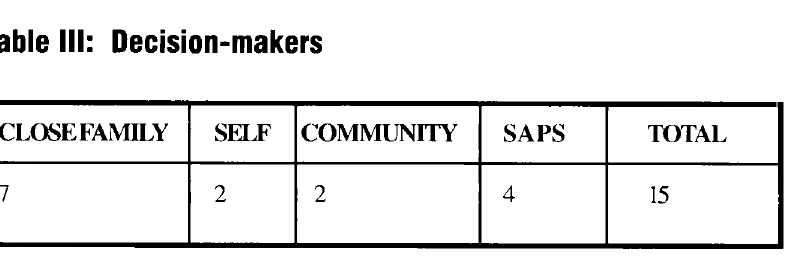
clients were satisfied with the mental health institution be­ cause positive and negative symptoms were disappearing.